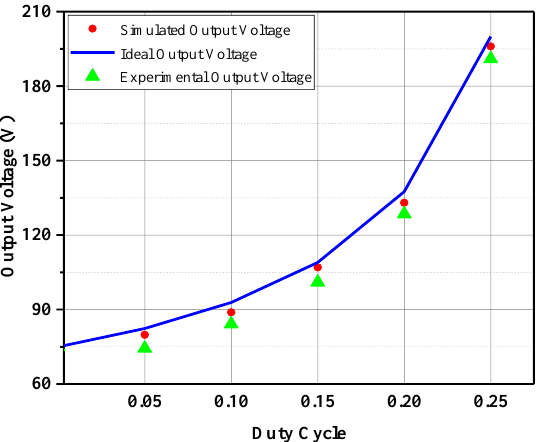
Figure 22. Ideal output voltage against the simulated output voltage with parasitic parameters and the experimental output voltage at different duty cycles.